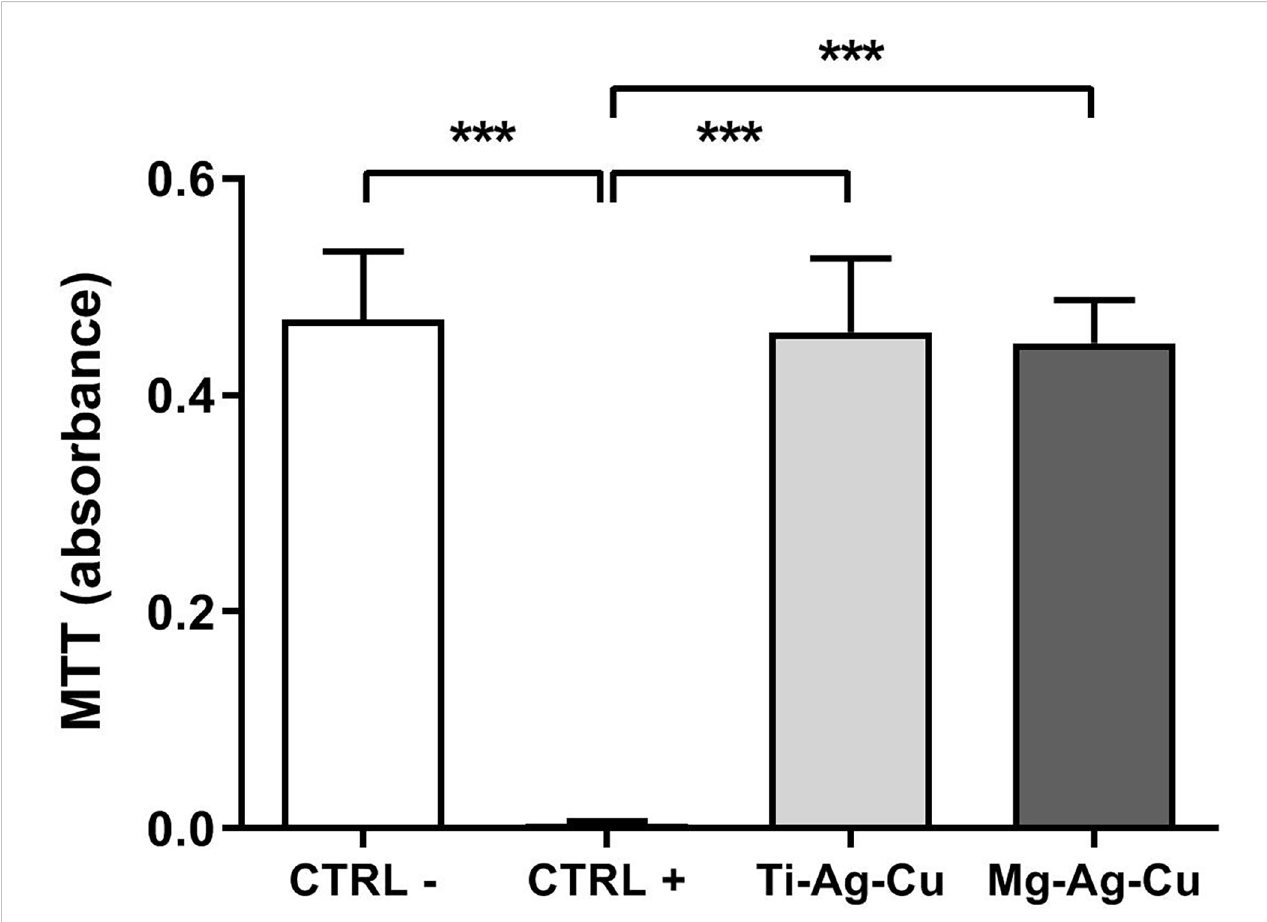
FIGURE 9 Effect of Ti-Ag-Cu and Mg-Ag-Cu coating on the viability of NIH 3T3 fi broblast compared to cells cultured in CM (CTRL -) and CM supplemented with 0.1% Triton-X100 (CTRL +) assessed by means of the MTT assay. Statistical signi fi cance: p < 0.001